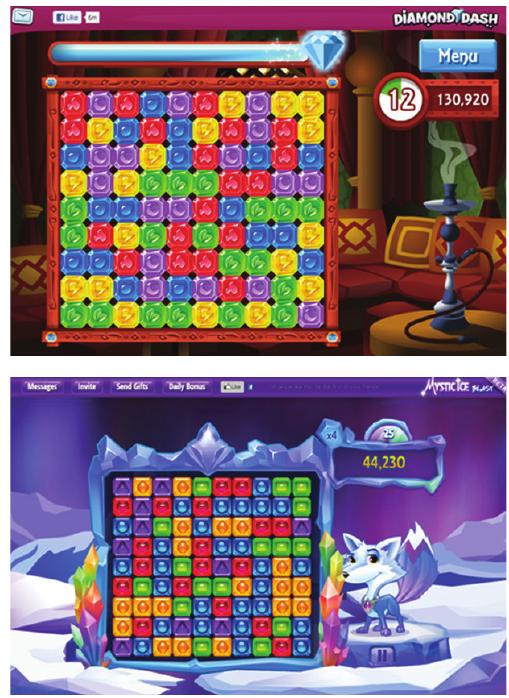
Figure 2: Comparison of the games Diamond Dash and Mystic Ice